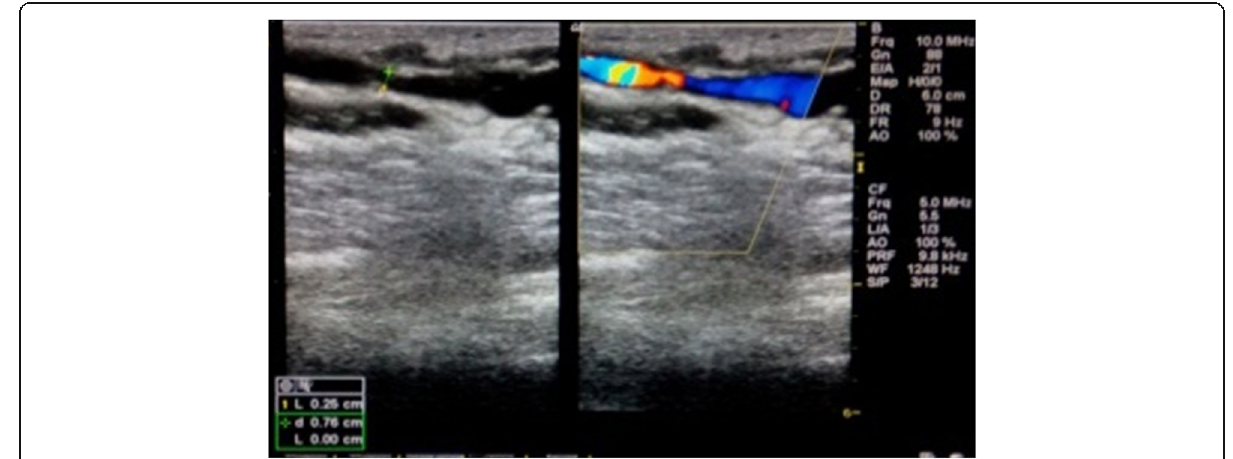
Fig. 3 Segmental narrowing of the cephalic vein with aliasing of the post-stenotic flow